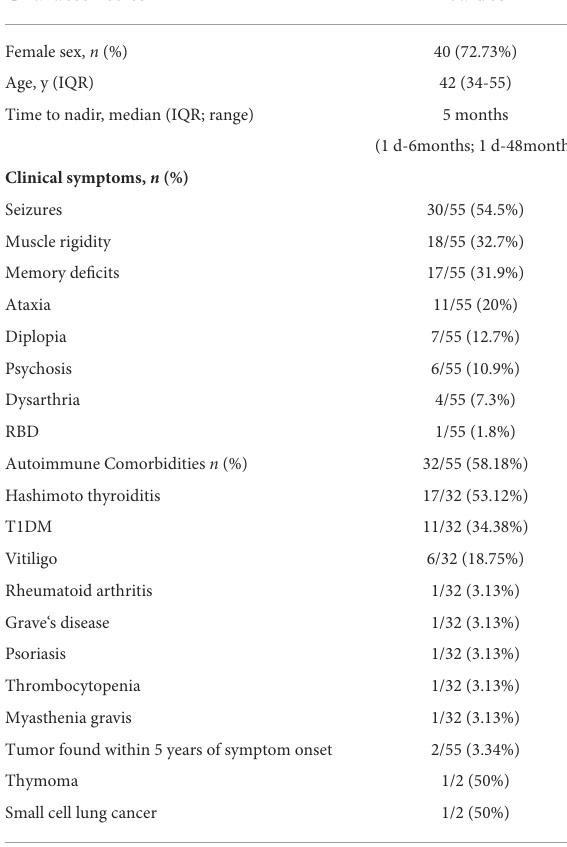
TABLE 1 Characteristics of the 55 patients with GAD65-ab associated with neurological autoimmunity.